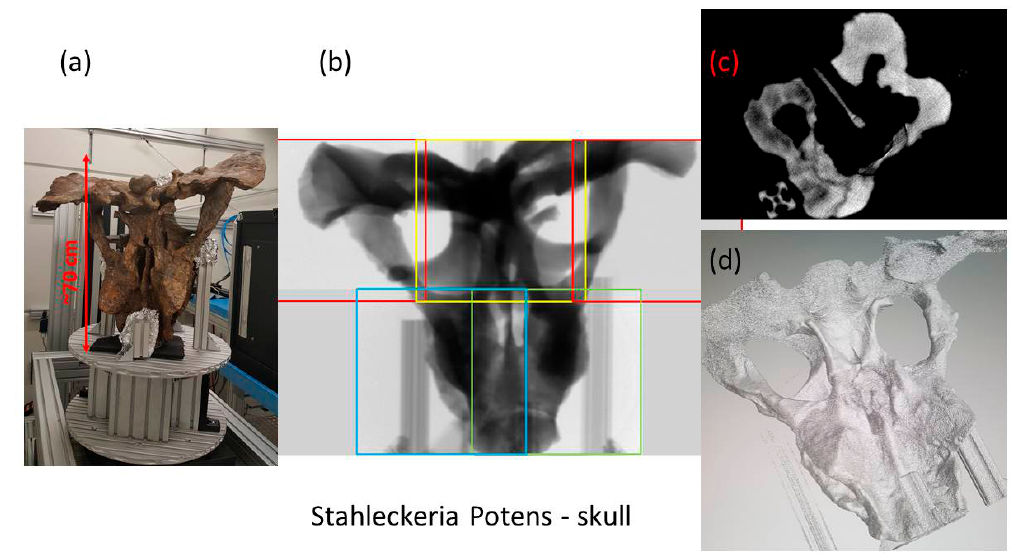
Figure 10. Tomography studies of the skull of Stahleckeria potens (GPIT/RE/7107) at the NECTAR facility; ( a ) photograph of the sample positioned at the sample stage; ( b ) a single projection (stitched five normalized radiographs); ( c ) a reconstructed tomography slice; ( d ) 3D visualization of the reconstructed object (original pictures).